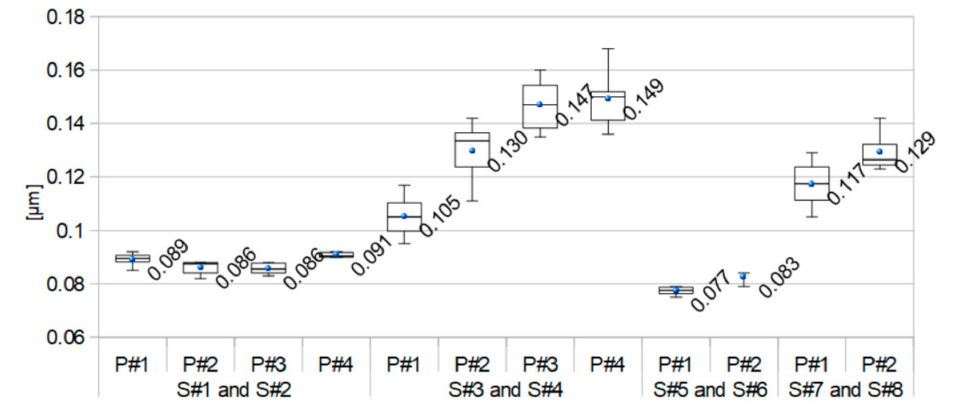
Figure 9. The center and spread of the Rdq parameter (the box plot presents the mean, the median, the interquartile range box, and the range of the data).